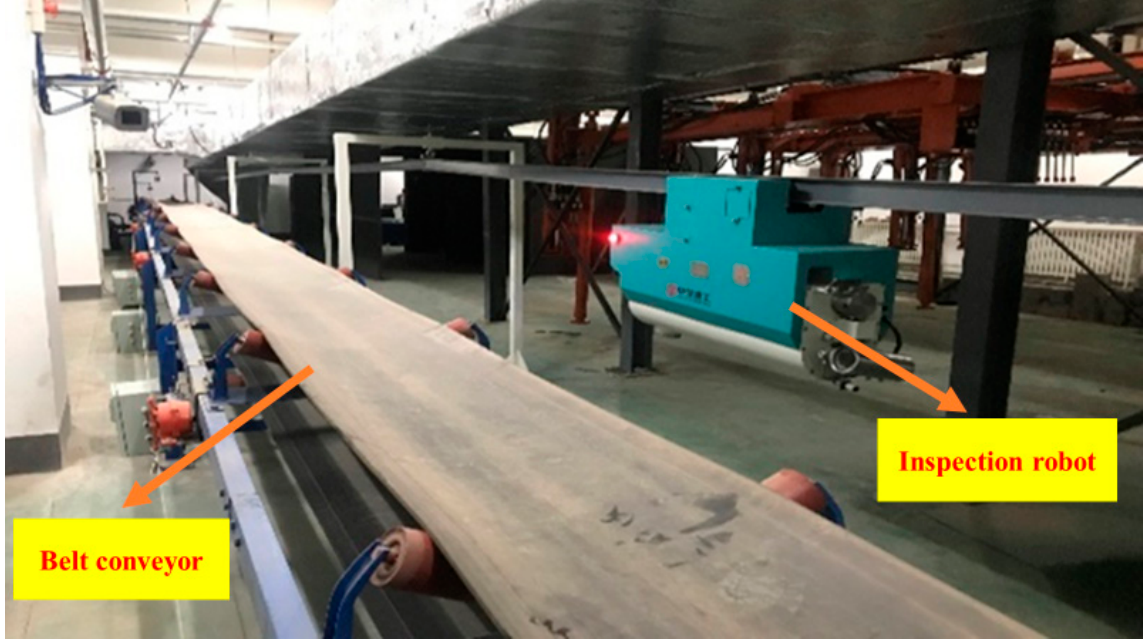
Figure 8. Working diagram of the underground inspection robot in coal